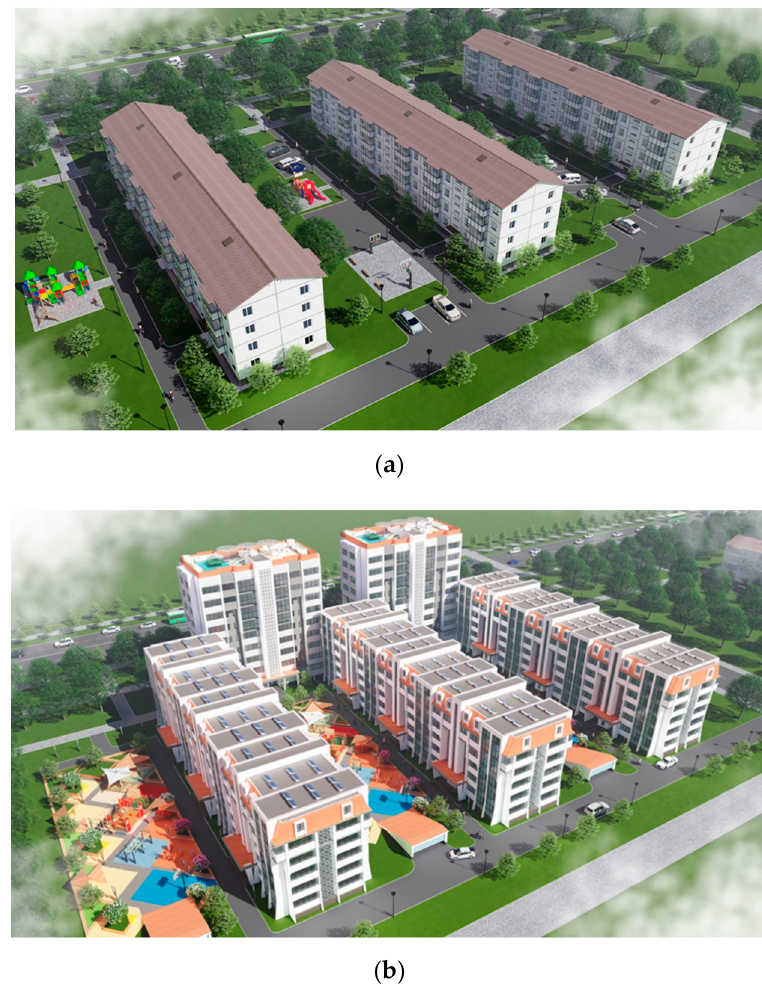
Figure 20. Project proposal (author’s) for the reconstruction of a residential group in Almaty: ( a ) before reconstruction; ( b ) after reconstruction (Author’s material).